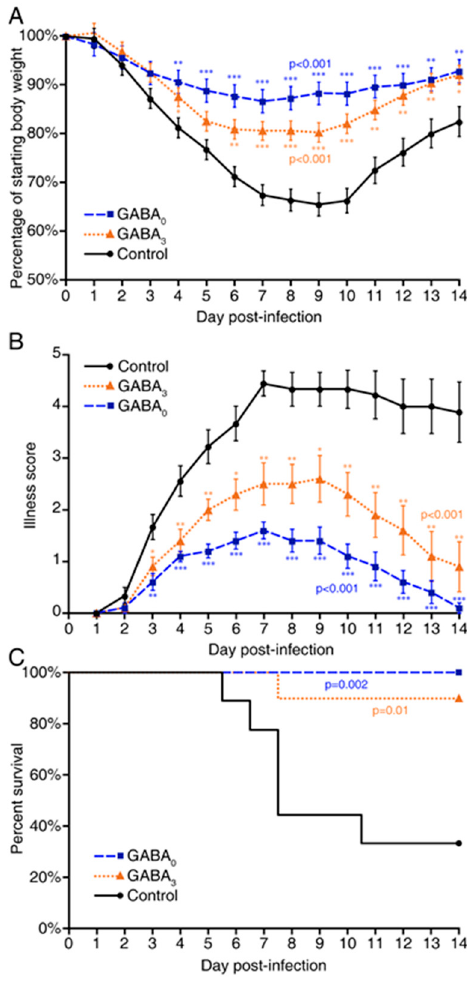
Figure 1. GABA treatment limits disease progression and death rate in MHV-1-infected mice. A/J mice were inoculated with MHV-1 intranasally and immediately placed on plain water (control, solid black line) or water containing 20 mg/mL GABA (GABA0, dashed blue line), or given plain water for 3 days post-infection and then placed on water containing 20 mg/mL GABA (GABA3, orange dotted line) for the remaining observation period: ( A ) Daily changes in mean % ± SEM body weight post-infection (% of day 0). GABA0 and GABA3 vs. control p < 0.001. GABA0 vs. GABA3 p = 0.159. Mean weight ratio profiles were computed under a repeated measure (mixed) analysis of variance model (RM ANOVA); ( B ) The animals were scored daily for the severity of their illness as detailed in Materials and Methods. The data shown are the mean illness scores +/ − SEM of each group from two separate experiments. Overall p < 0.001 for GABA0 and GABA3 vs. control, and p = 0.042 for GABA0 vs. GABA3 using the Kruskal–Wallis test. Individual p values indicated as * p < 0.05, ** p < 0.01, *** p < 0.001; ( C ) Daily percent of surviving mice in each group. GABA0 and GABA3 vs. control p = 0.002 and p = 0.01, respectively by log-rank test. GABA0 vs. GABA3 p = 0.32. n = 9 mice in the control group, 10 mice in each GABA-treated group. Individual mouse identification